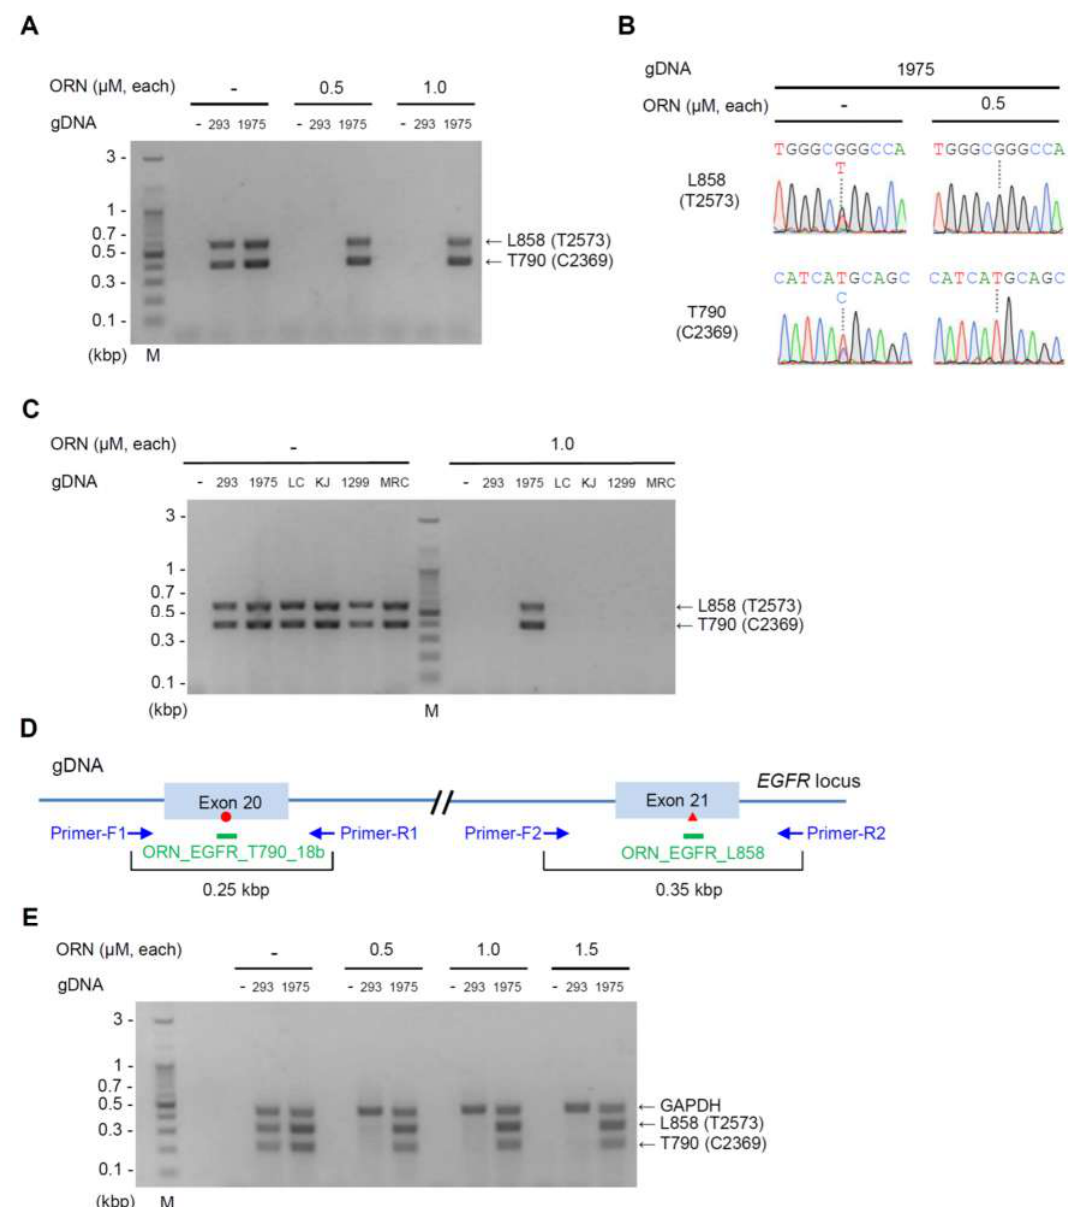
Figure 3. Multiplex ORNi-PCR for simultaneous detection of the T790M (C2369T) and L858R (T2573G) mutations in gDNA. ( A ) Results of multiplex ORNi-PCR with ORN_EGFR_T790_18b and ORN_EGFR_L858. Primer sets shown in Figure 2B and Supplementary Figure S1B were used simultaneously. ( B ) Results of DNA sequencing analysis. Amplicons of PCR or ORNi-PCR (0.5 μM each ORN) shown in ( A ) were subjected to DNA sequencing analysis. Sequencing signals around T790 (C2369) and L858 (T2573) are shown. ( C ) Results of multiplex ORNi-PCR with gDNA extracted from various lung cell lines. ( D ) Primer positions for multiplex ORNi-PCR combined with an internal control PCR. Primer positions for multiplex ORNi-PCR are shown. Primers for amplification of the GAPDH gene were used as an internal control PCR. The red circle and triangle represent the T790M (C2369T) and L858R (T2573G) mutations, respectively. ( E ) Results of multiplex ORNi-PCR combined with internal control PCR.